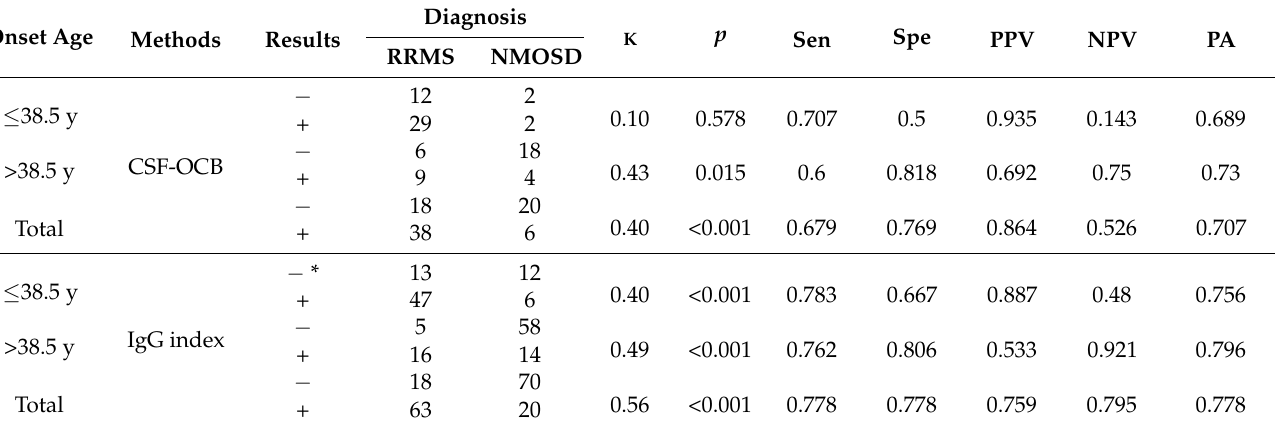
Table 2. Comparison of the IgG index and CSF-OCB for differentiating between RRMS and AQP4-Ab NMOSD based on the stratification of the onset